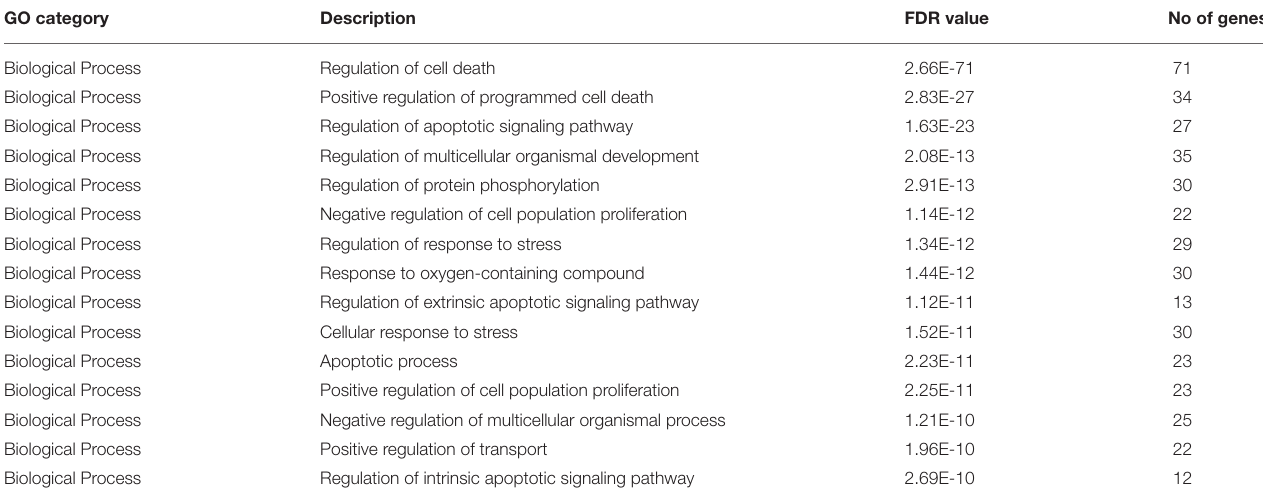
TABLE 5 | Gene ontology (GO) terms with the strongest enrichment in the analysis of the differentially upregulated transcripts in the comparison between alpha-synuclein-overexpressing and GFP-expressing LUHMES